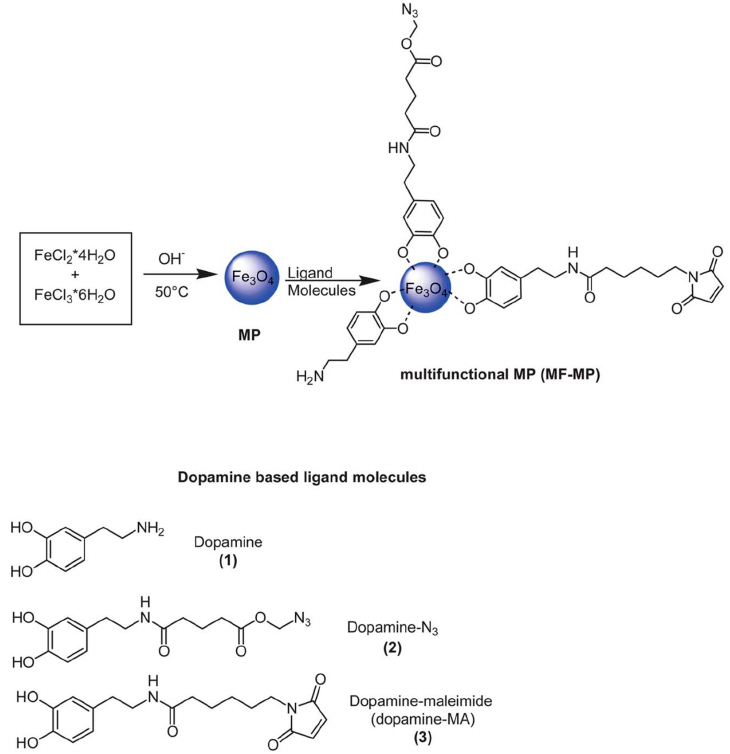
Figure 4. Schematic illustration of the formation of magnetic fluid-multifunctional magnetic nanoparticles (MF-MPs) based on the use of differently functionalized dopamine derivatives. Reprinted with permission from Reference [125].